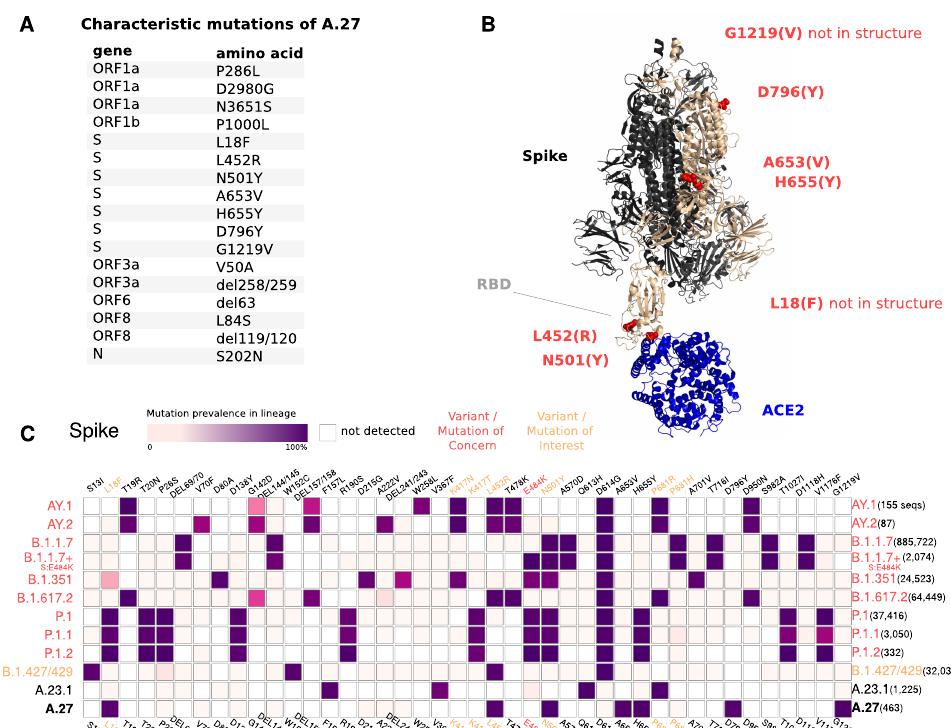
Figure 3. ( A ) Characteristic (lineage-defining) mutations of A.27 derived from https://outbreak.info. ( B ) The trimeric spike protein of SARS-CoV-2 (PDB: 7kj2, [19]) is depicted in complex with its cellular receptor ACE2. The variant residues of lineage A.27 are labeled on one subunit with the A.27 amino acids indicated in parentheses. RBD—receptor binding domain. ( C ) Mutation profiles of selected VOC/VOI in comparison to A.27 and A.23.1 obtained from https://outbreak.info (accessed on 23 June 2021)